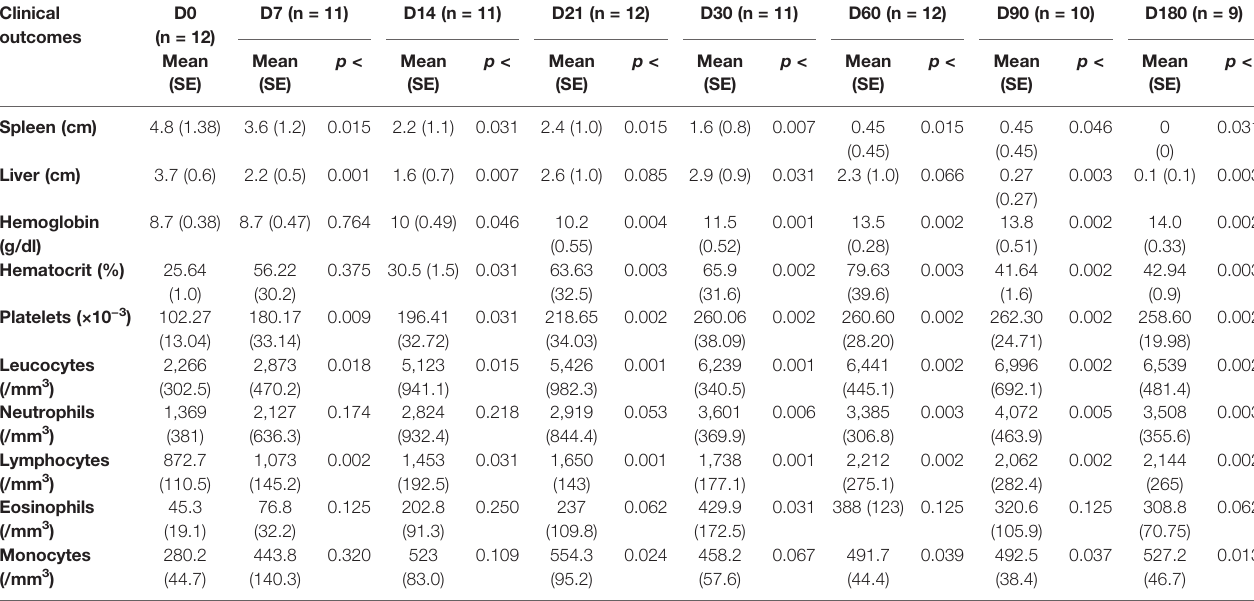
TABLE 1 | Clinical outcomes of VL patients. Clinical